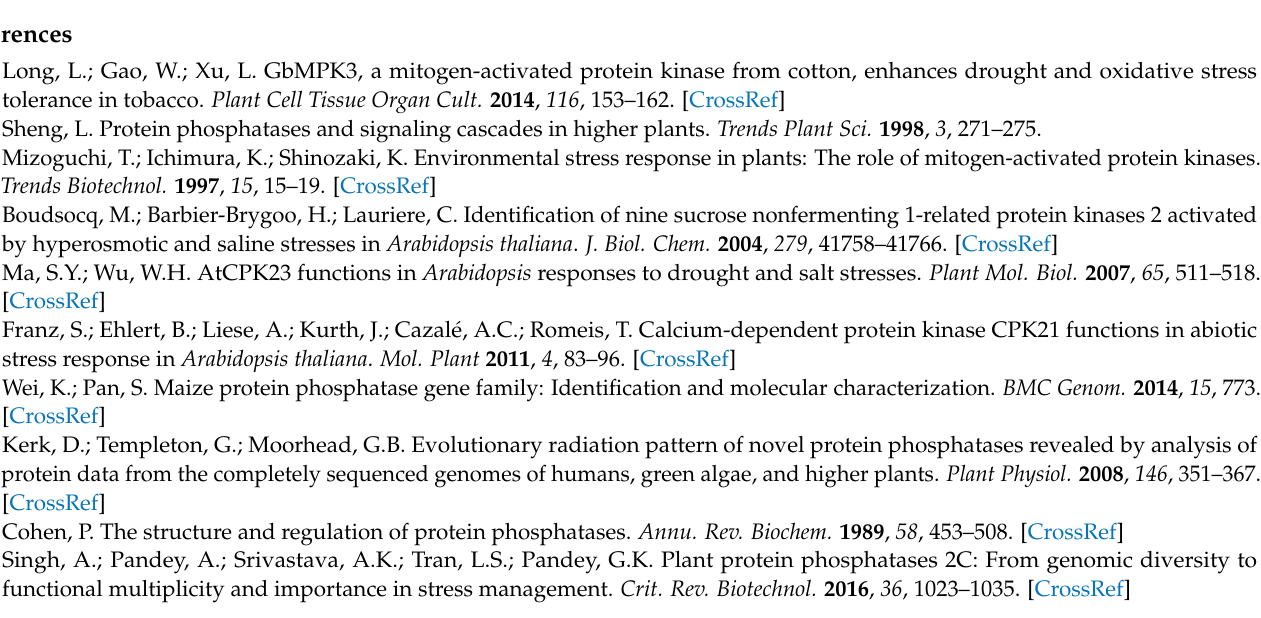
Table S3: The PP2C gene family of Arabidopsis and rice; Supplementary Table S4: Total number of PP2C genes participating in the synteny relationship; Supplementary Table S5: The syntenic PP2C gene pairs in tomato, Arabidopsis, rice, and between them; Supplementary Table S6: KaKs of all SlPP2Cs tandem repeat gene pairs; Supplementary Table S7: Cis-elements identified in the promoters of SlPP2Cs ; Supplementary Table S8: Expression of PP2C genes in different Henzi tomato tissues; Supplementary Table S9: Information of probe sets used for microarray expression analysis. Author Contributions: The work presented here was carried out in collaboration between all